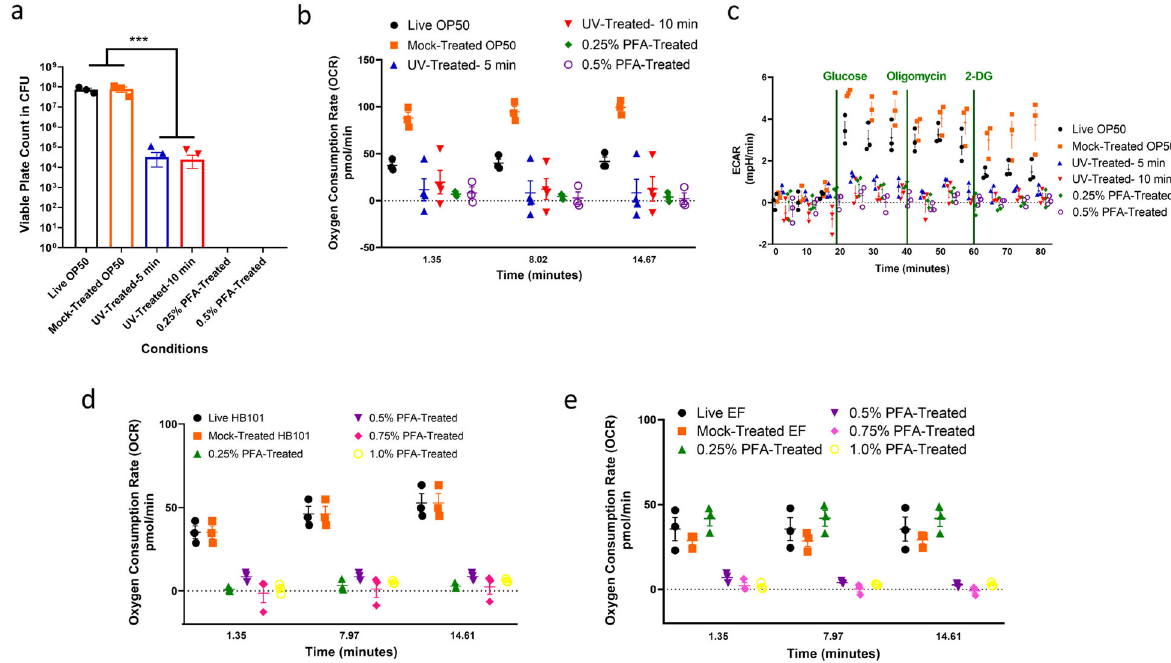
Fig. 2 Paraformaldehyde treated nonpathogenic and pathogenic bacteria are replicatively and metabolically dead. a Bacteria growth in colony-forming units (CFU) of various OP50 conditions. Respiration determined using b Oxygen consumption rate (OCR) of live and treated bacteria in pmol/min. c Extracellular acidi fi cation rate (ECAR) in mpH/min of all OP50 conditions and OCR of live and treated conditions of d HB101 and e E. faecalis in pmol/min. Triple asterisks denote p -value <